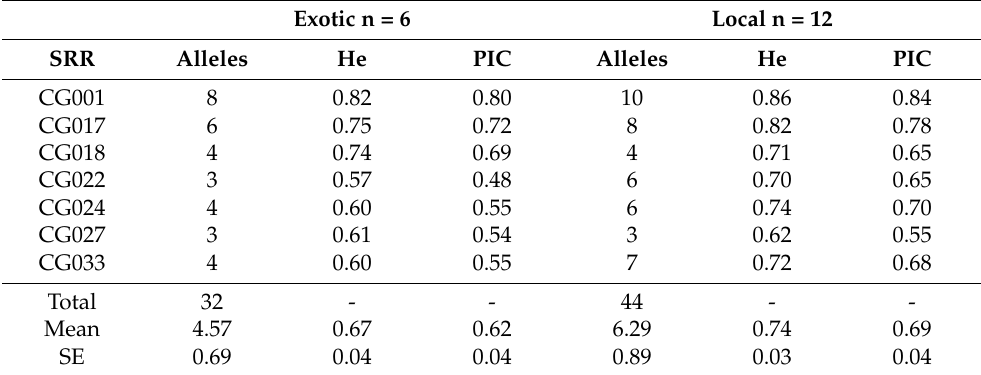
Table 8. Number of alleles, polymorphic information content found in the seven microsatellites between the exotic and local spider plant accessions.